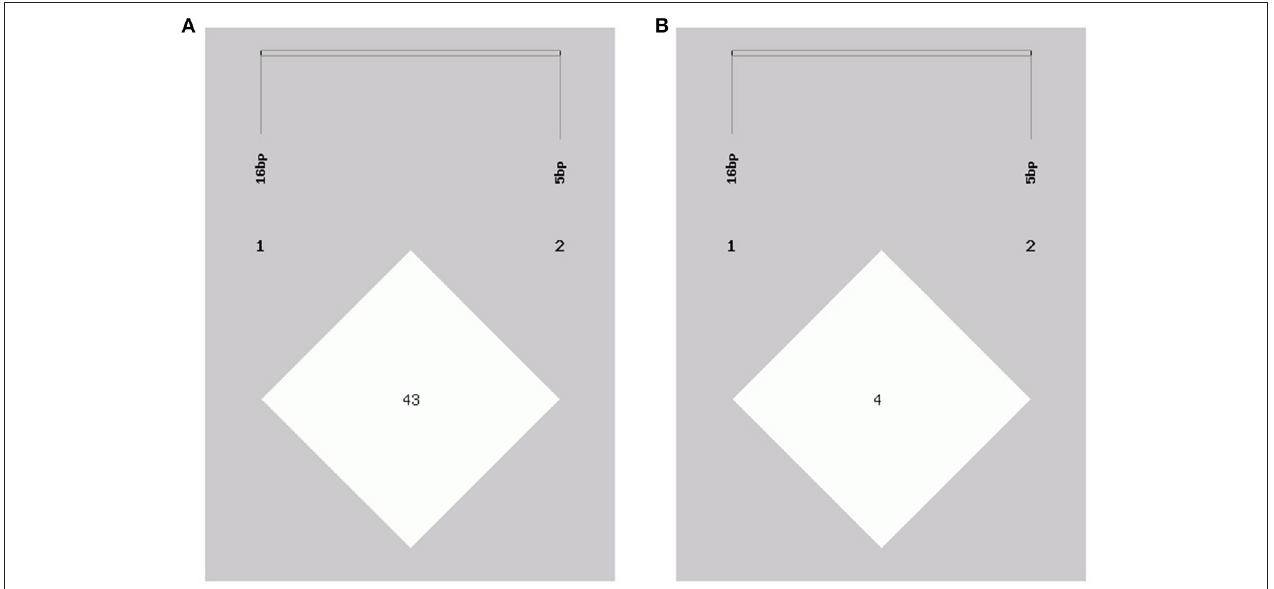
FIGURE 5 | Linkage disequilibrium plot of the KDM6A gene two indel loci. (A) D’ value, (B) r 2 value.